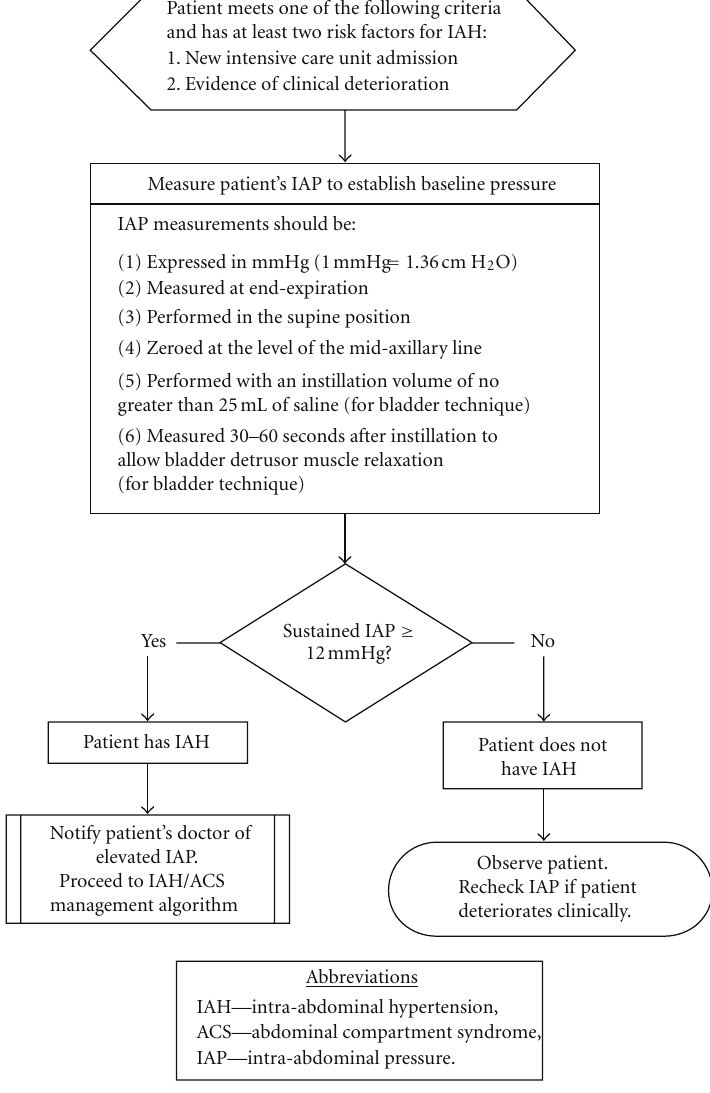
Figure 1: From: Cheatham et al. [25] Intensive Care Med. 2007 Jun;